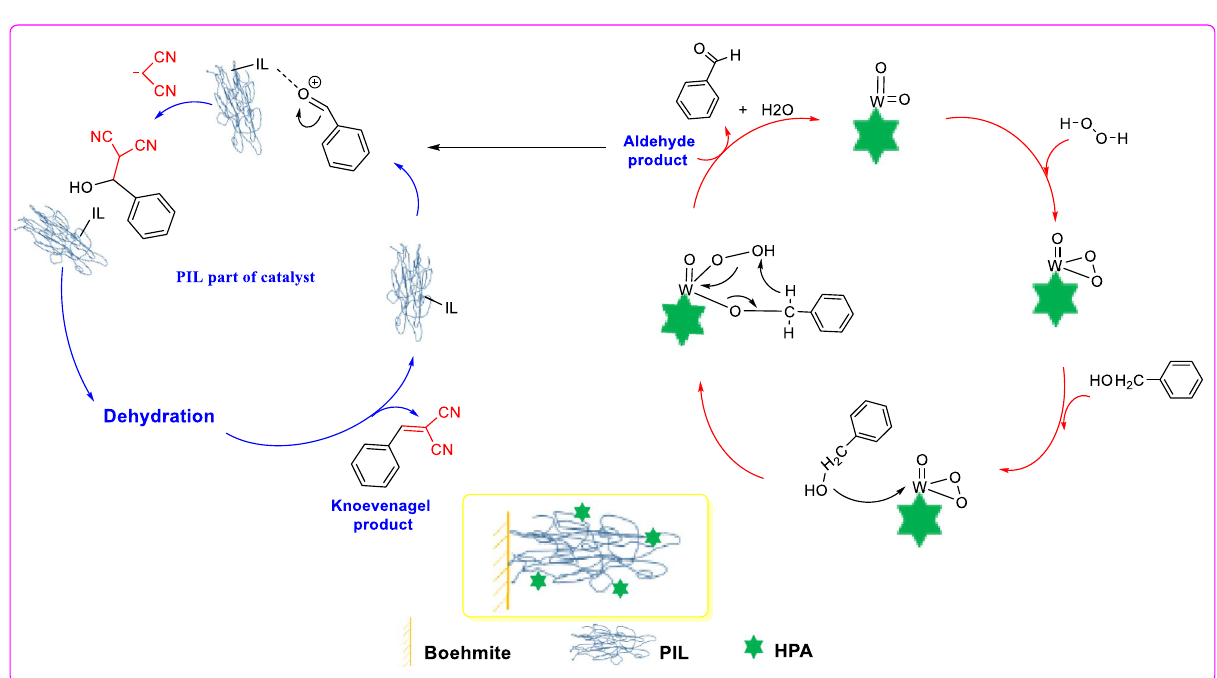
Figure 11. The proposed mechanism for tandem alcohol oxidation/Knoevenagel condensation